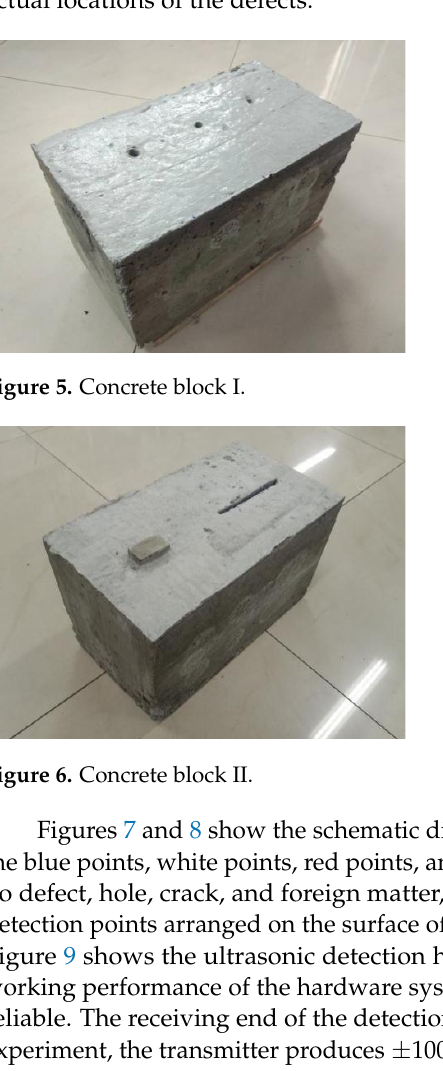
Figure 8. Block II detection position. Figure 9. Ultrasonic detection hardware system. Table 1. The size and category of datasets. Category